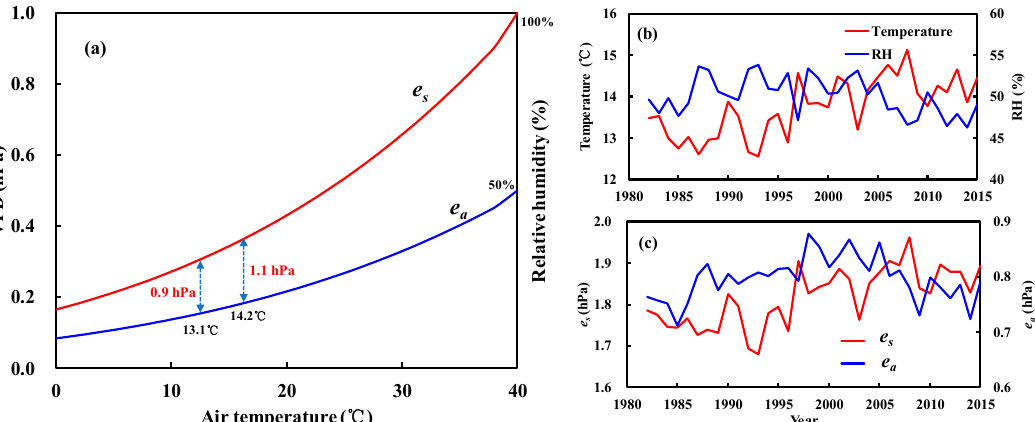
Figure 10. Spatial distributions of the VPD trends over Xinjiang, China, from 1982 to 2015 ( a ) and the two periods of 1982–1996 ( b ) and 1997–2015 ( c ). A solid circle indicates a 95% confidence level. ( d ) The difference of VPD trends before and after TP years. Positive values denote the higher VPD trends after TP years.